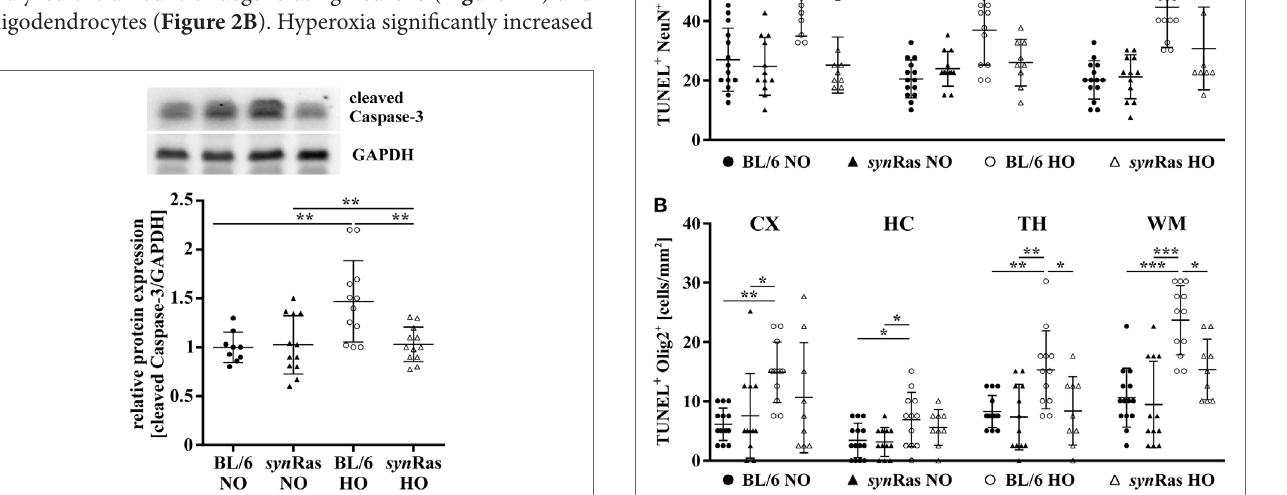
FigUre 2 | Hyperoxia-induced neuronal and oligodendrocyte degeneration is ameliorated in syn Ras mice. Brain sections from P7 mice either exposed to normoxia [21% oxygen (NO)] or hyperoxia [24 h, 80% oxygen (HO)] at P6 in syn Ras mice or their respective wild-type littermates (BL/6) were analyzed. Neuronal (NeuN) (a) and oligodendrocyte (Olig2) (B) degeneration was determined in cortical (CX), hippocampal (HC), thalamic (TH), and white matter (WM) regions by double-labeling with TUNEL (* p < 0.05, ** p < 0.01, and *** p < 0.001).